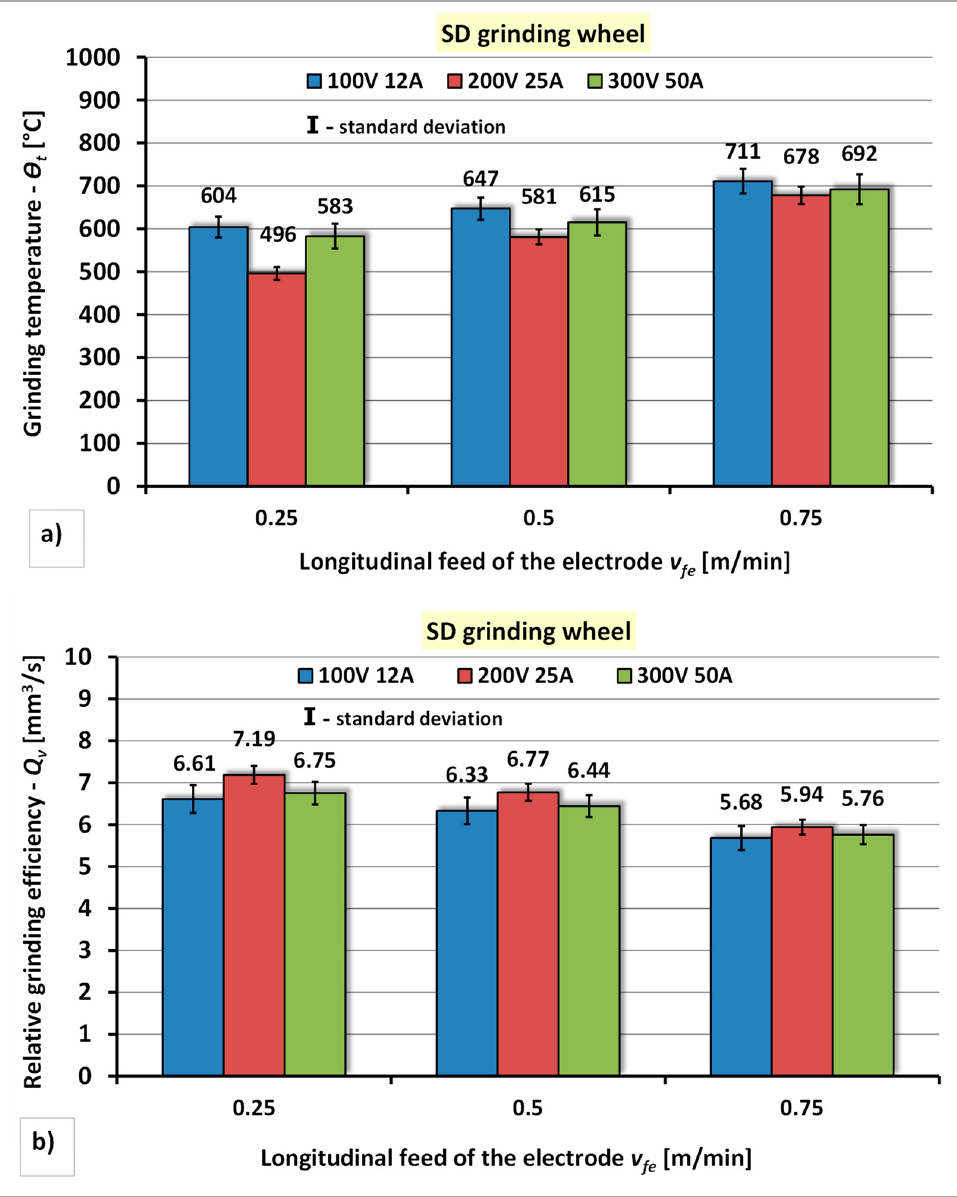
Figure 11. The effect of the generator power and longitudinal feed of the electrode during electrodischarge dressing of a diamond grinding wheel using a segmental electrode: ( a ) On the grinding temperature— Θ t ; ( b ) On the relative grinding efficiency— Q v .